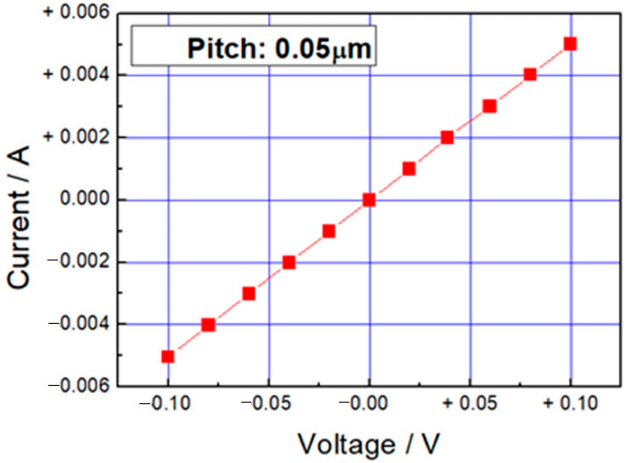
Figure 8. I-V characteristics of the photofabricated PEDOT line pattern in the Nafion 212 sheet (Thickness: 50 µ m). The photofabrication was carried out by using an oil immersion objective lens (NA:1.42) and a laser focus scanning with a pitch of 0.05 µ m, a wait of 100 ms, incident laser exposure of 0.041 mWs, and a repetition rate of 8